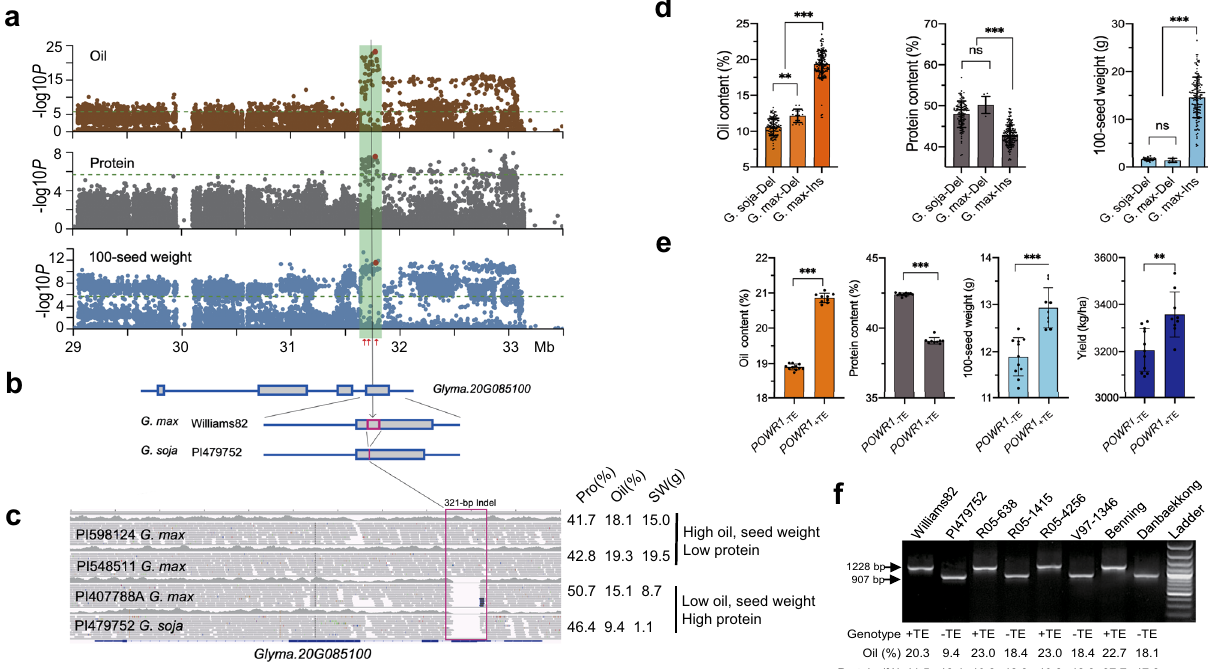
Fig. 1 Identi fi cation of the causative gene and allele underlying a large effect oil, protein, and seed weight QTL on chr20. a Manhattan plots illustrating associations of oil, protein content, and 100-seed weight with SNPs and InDels across the 4-Mb interval on chr20. The 154-kb region is highlighted in green. The 321-bp InDel (red dots) and the signi fi cance threshold after Bonferroni correction (horizontal dotted lines) are shown. The red arrows at the bottom of the panel mark the locations of the three most signi fi cantly associated SNPs identi fi ed in GWAS RIL . b Gene structure of Glyma.20G085100 with and without the 321-bp InDel (red box). c Sequencing read alignments of Glyma.20G085100 from two high oil/low protein accessions and two low oil/high protein accessions showing the 321-bp InDel. Seed oil (Oil), protein (Pro) content, and 100-seed weight (SW) of each accession are shown. d , e Allelic effect of the 321-bp InDel on oil, protein, 100-seed weight, and yield among the association panel d ( n = 116, 8, and 154 for G. soja -Del, G. max -Del, and G. max -Ins, respectively) and among NILs ( e ) ( n = 12). Trait values are shown as the mean ± SD (standard deviation). Statistical signi fi cance was determined by one-way ANOVA for the association panel and by two-tailed unpaired Student ’ s t test for the NILs. * p < 0.05, ** p < 0.01, and *** p < 0.001. Trait values are shown as the mean ± SD (standard Derivation). f PCR genotyping assay for the TE insertion in parental lines of four RIL populations. PCR amplicons of 1228 bp and 907 bp represent the presence and absence of the TE insertion, respectively. Genotypes for TE insertion, and oil and protein content for each accession are shown. This experiment was repeated twice. Source data are provided as a Source Data fi